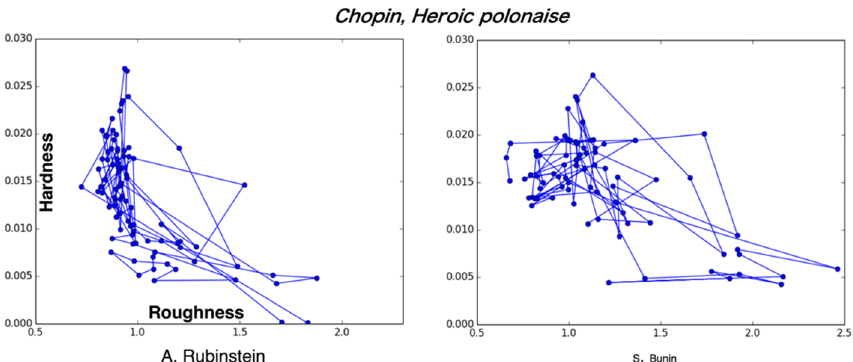
Figure 3. Tactile qualities of notes played by Rubinstein ( left ) and Bunin ( right ) on Chopin’s Heroic Polonaise . The vertical axis indicates hardness; the horizontal axis indicates roughness. The graphs plot the average hardness and roughness of the notes played every 0.01 s.